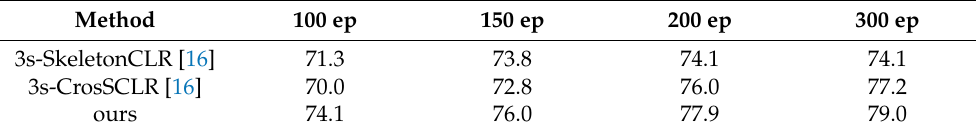
Table 3. Linear evaluation results on NTU-60 xsub for different epochs.